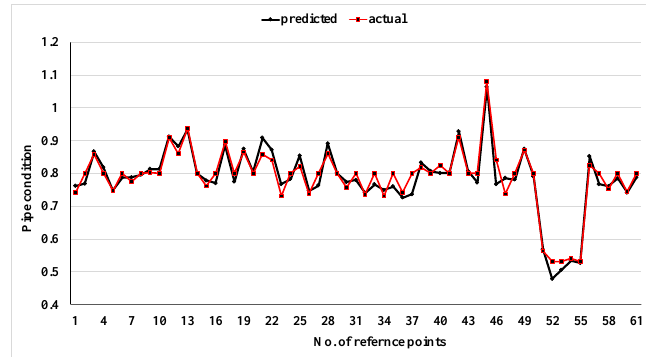
Figure 10. Plot for actual ERF vs predicted ERF.